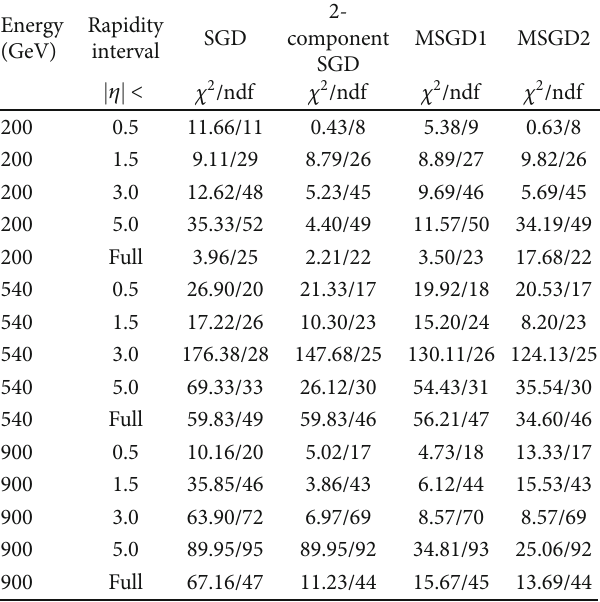
Table 2: χ 2 /ndf for charged multiplicity distribution fi tted with shifted Gompertz, 2-component modi fi ed shifted Gompertz, MSGD1, and MSGD2 distributions for di ff erent rapidity windows in p (cid:1) p